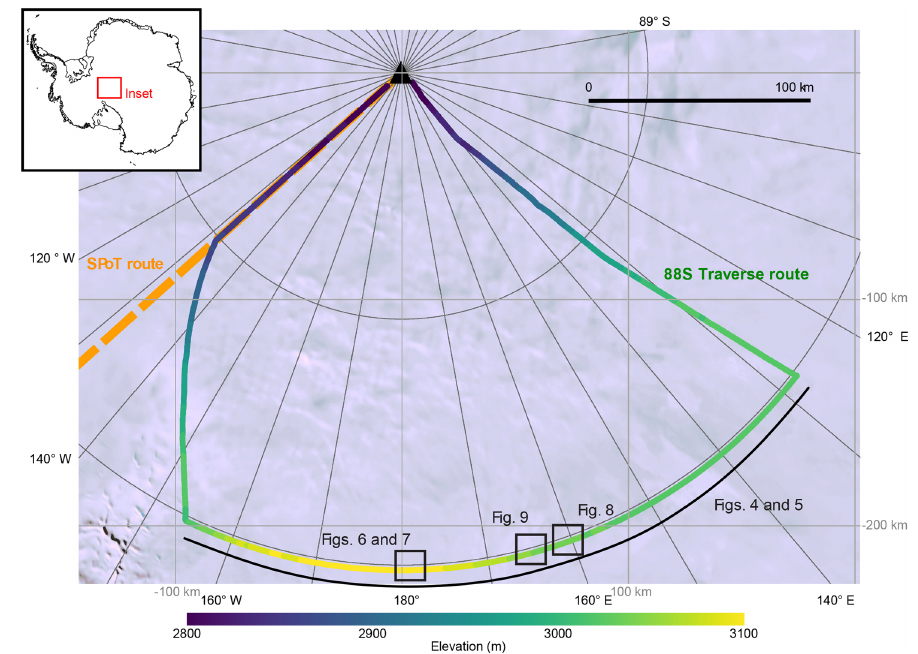
Figure 1. Map of the 88S Traverse route, color coded based on elevation. Locations for Figs. 4–9 are also shown. The South Pole Operational Traverse (SPoT) route is indicated in orange. Background is the Landsat image mosaic of Antarctica (LIMA; Bindschadler et al.,